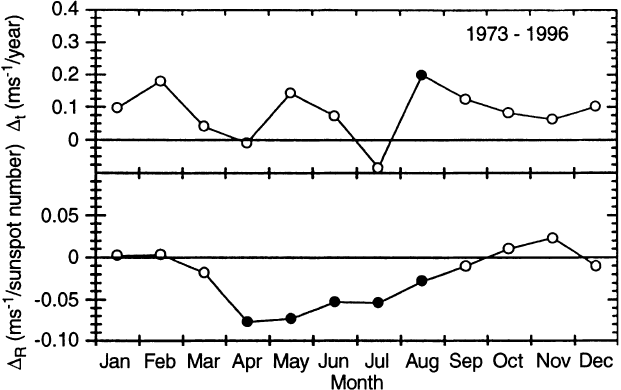
Fig. 2. Coe(cid:129)cients D (trend) and D (solar cycle dependence) for the t R zonal prevailing wind, calculated using Eq. (2) for each month. Solid symbols denote significance on the 95%-level (after Jacobi et al. , oz